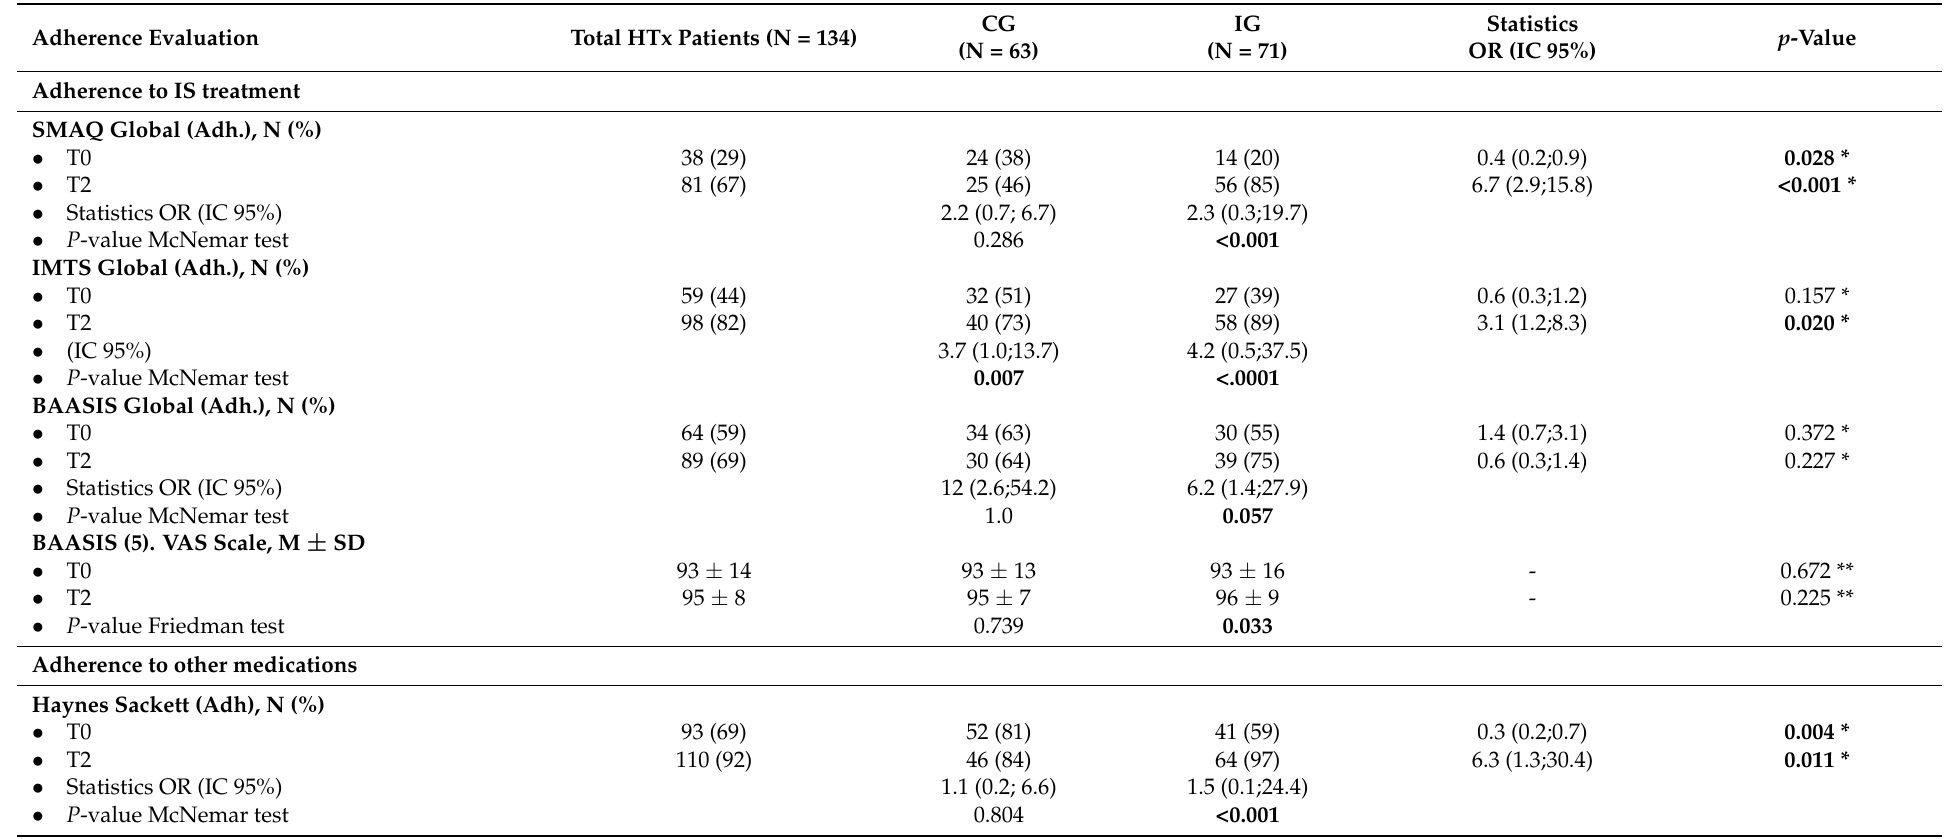
Table A1. Medication adherence improvement over time (T0 vs. T2) and between the control (CG) and intervention (IG)